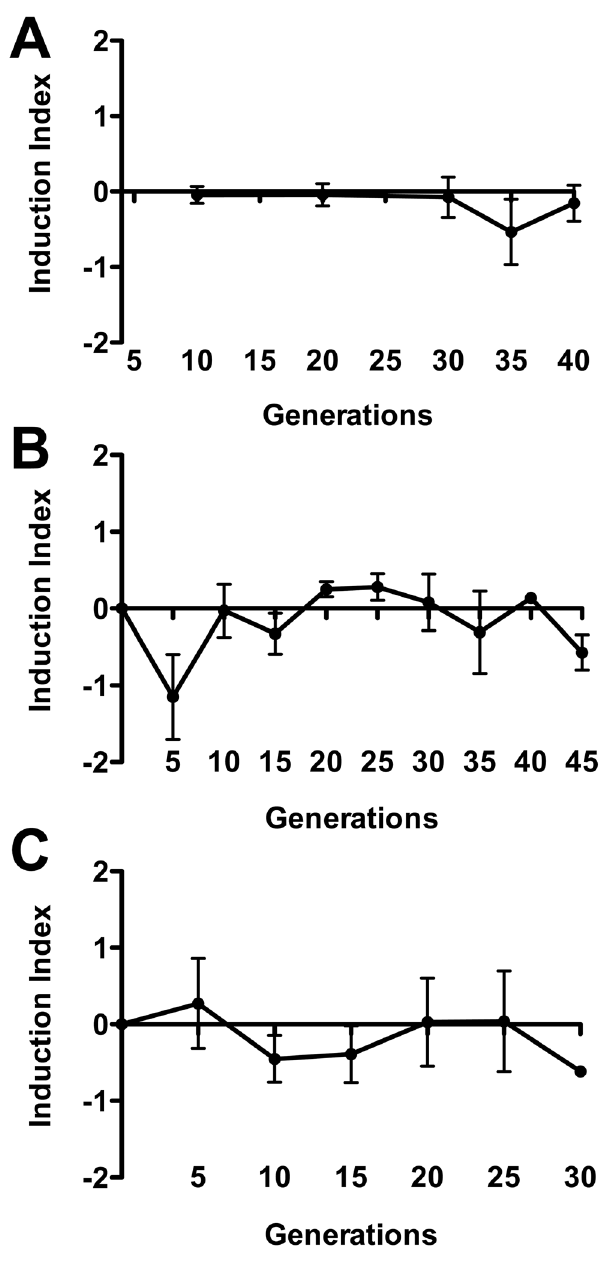
Figure 6. Measurement of in vitro prophage induction. SIVET strains were grown in LB broth and serially diluted into fresh LB. Cultures were grown to desired densities and concentrations of CamR and KanR bacteria in cultures measured at indicated points in growth cycle. Multiple rounds of dilutions and growth allowed for indicated rounds of duplication. Where appropriate, low dilutions ensured that any CamR bacteria would be carried over during dilutions. Graphs show ratios of CamR/KanR on a log scale (calculated using the Induction Index formula) over the indicated number of generations. A. SIVET cIind1 strains K11607 (locked in KanR form) and K11608 (CamR) were grown together in LB to stationary phase at which time bacterial counts were determined and dilutions were made for next round of growth. Error bars represent standard error of the mean. B. Cultures of K11604 were grown to stationary phase at which time bacterial counts were